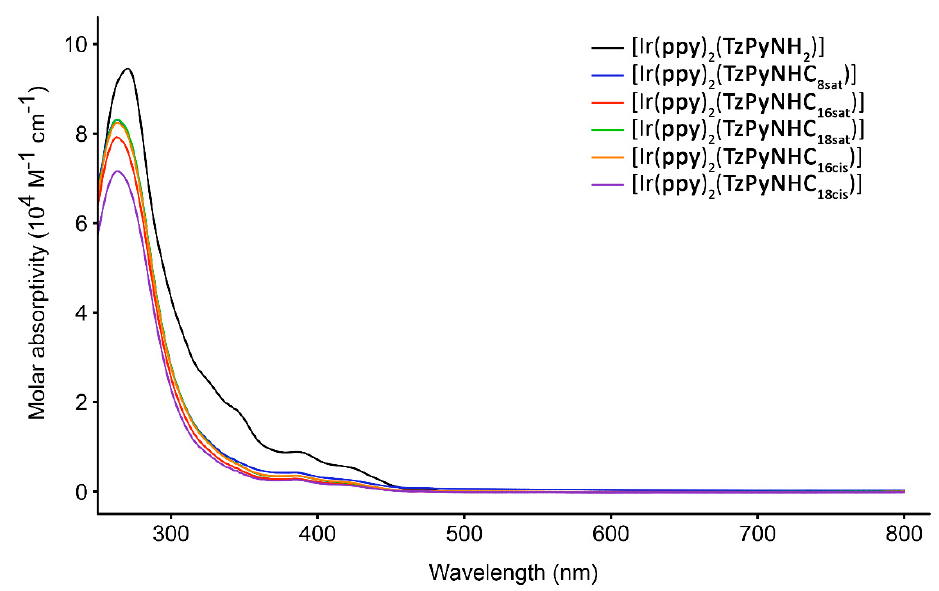
Figure 2. Absorption spectra of the iridium complexes from 10 − 5 M dichloromethane solutions. Selected emission spectra for [Ir( ppy ) 2 ( TzPyNHC 16sat )] and [Ir( ppy ) 2 ( TzPyNHC 16cis )] are shown